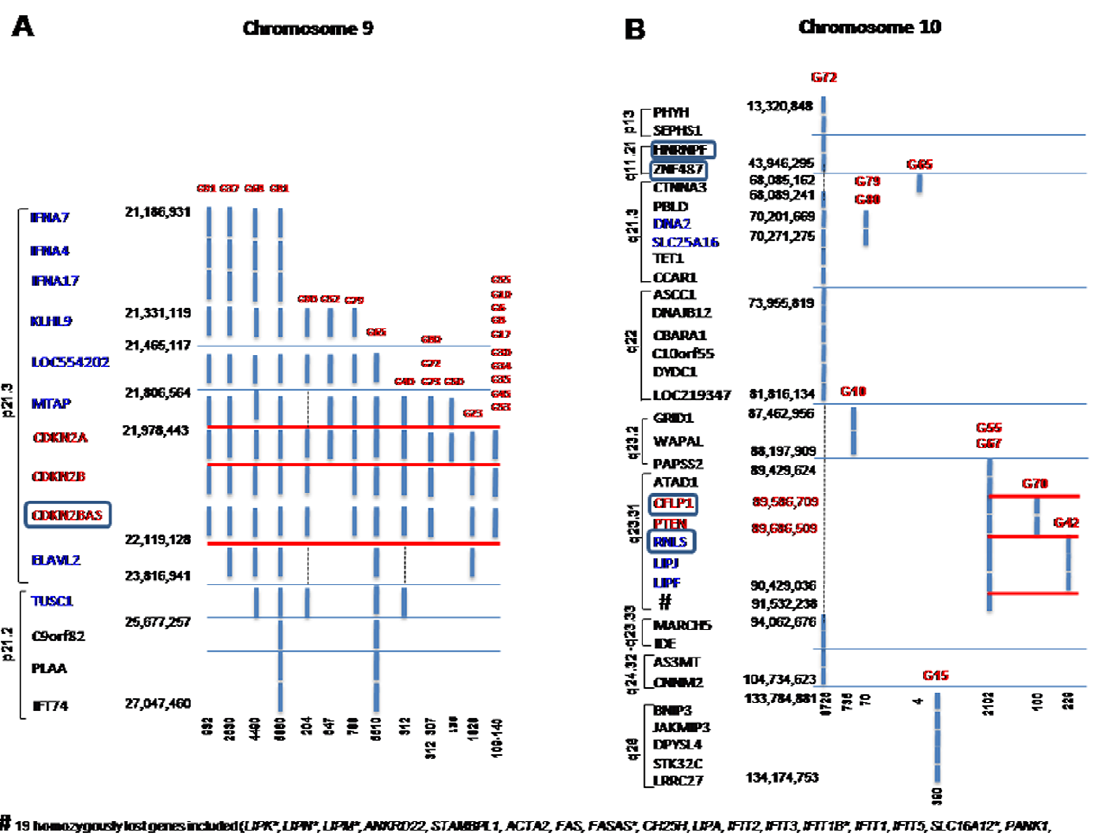
Figure 2. Frequently homozygously deleted chromosomal regions in GBM. Recurrent homozygously deleted segments of chromosomes 9 (9p21.2 and 9p21.3) (A) and 10 (10p13, 10q11, 10q21, 10q22, 10q23, 10q24 and 10q26) (B). The identification code for each tumor is placed on top of each line (G–N.), the length of the deleted chromosomal region in Kb is placed at the bottom of the lines corresponding to each deleted region, and both the starting and ending positions of the deleted segments are shown at the left of each chromosomal region. All genes coded in each deleted chromosomal region are displayed: previously reported candidate genes deleted in a significant number of cases are shown in red, other recurrently deleted genes are depicted in blue, while genes deleted at low frequencies are shown in black.. Genes without expression values in the array are highlighted with square boxes in the figure.